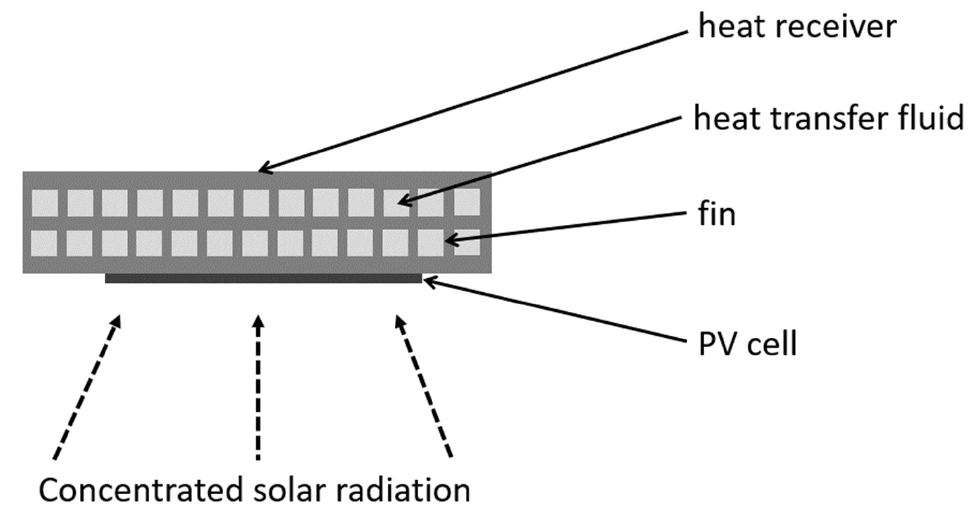
Figure 31. The cross-sectional view of a heat receiver with double-layer of microchannels.